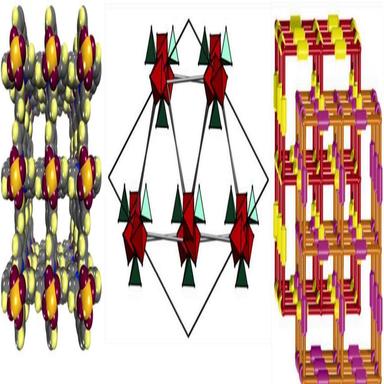
Three HUM platforms are each comprised of organic linkers, inorganic anions and the same transition metal MBBs: linear pillared HUMs (left); angular pillared HUMs (middle); interpenetrated HUMs (right).